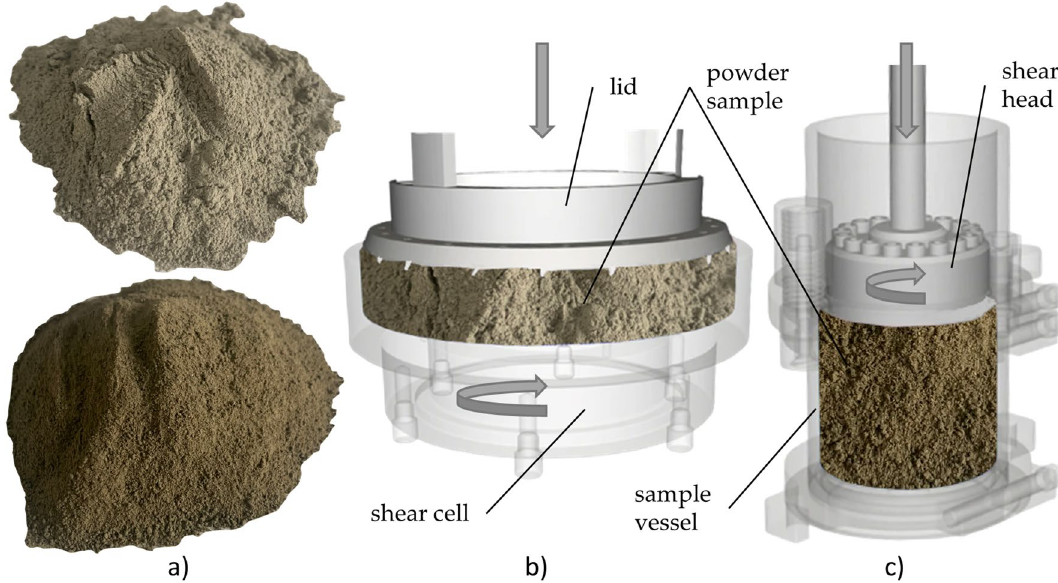
Figure 4. ( a ) Lunar regolith simulant LHS-1 (above) and LMS-1 (bottom); ( b ) Schulze’s shear test setup; ( c ) FT4’s shear test setup. This figure was created in Gimp